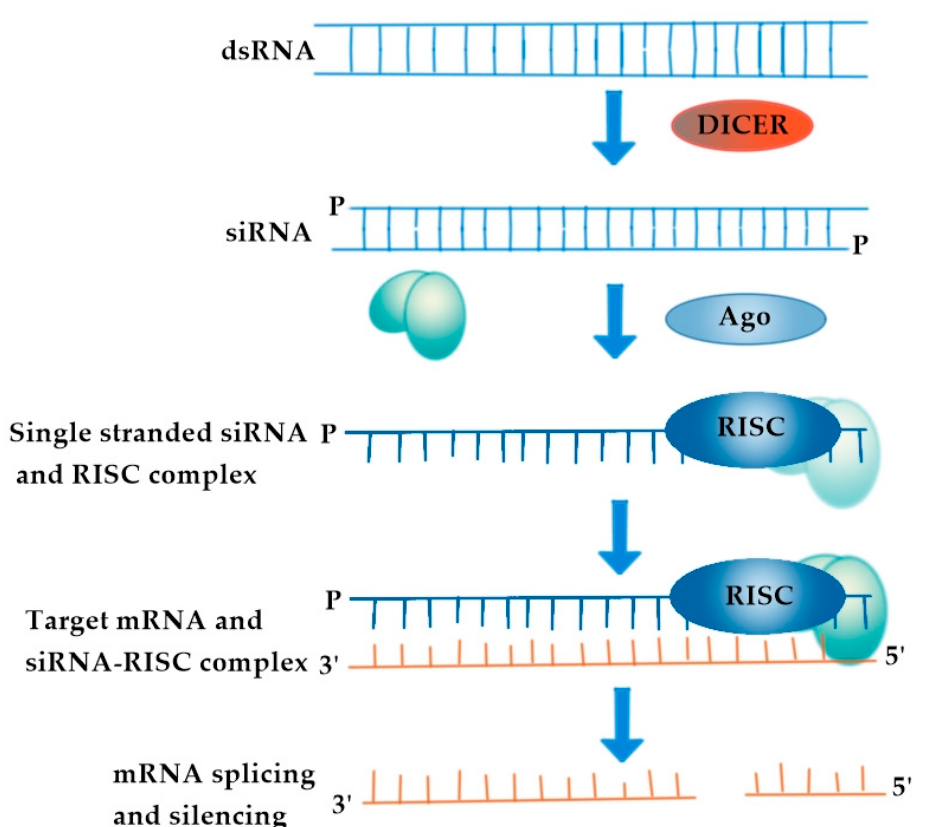
Figure 8. Mechanism of siRNA activity. RNA-induced silencing complex (RISC complex) is composed of Dicer and Argonaute protein (AGO).